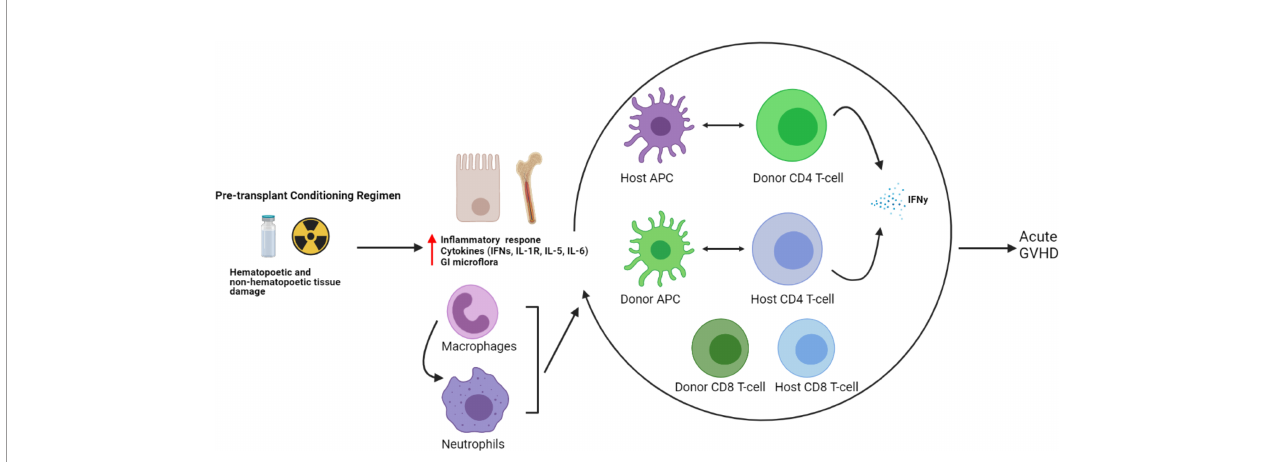
FIGURE 2 | Host and donor immune cell interactions and pathogenesis of acute GVHD. The current understanding of acute GVHD pathogenesis involves a complex interaction of host and donor immune cells.